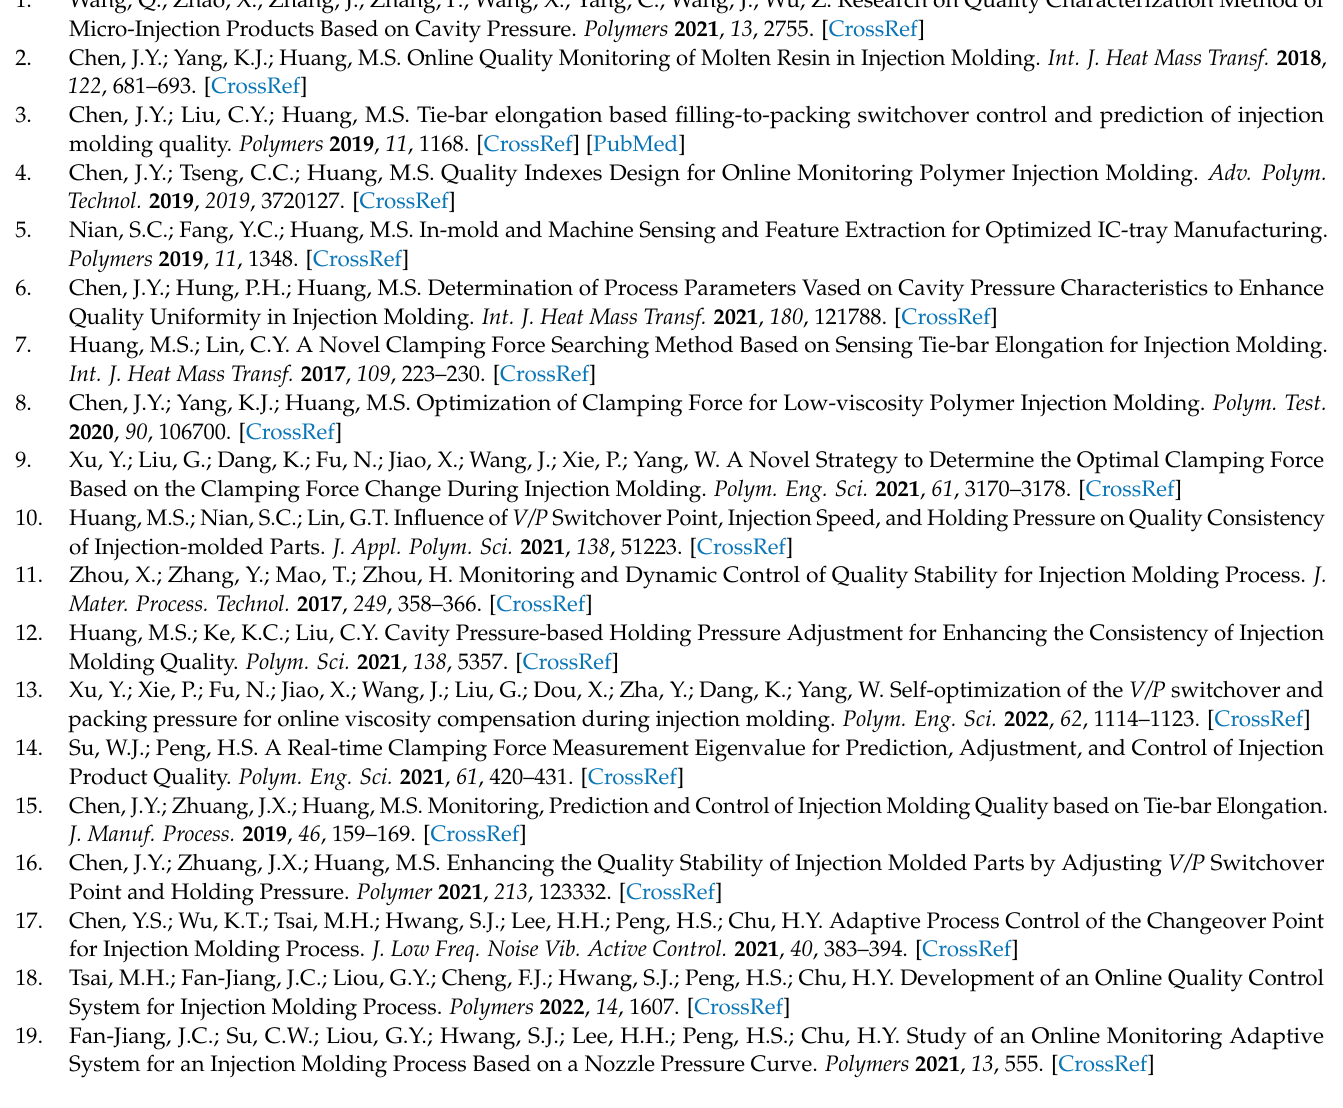
Figure A6. Nozzle pressure profiles of PT231 at different packing pressures.